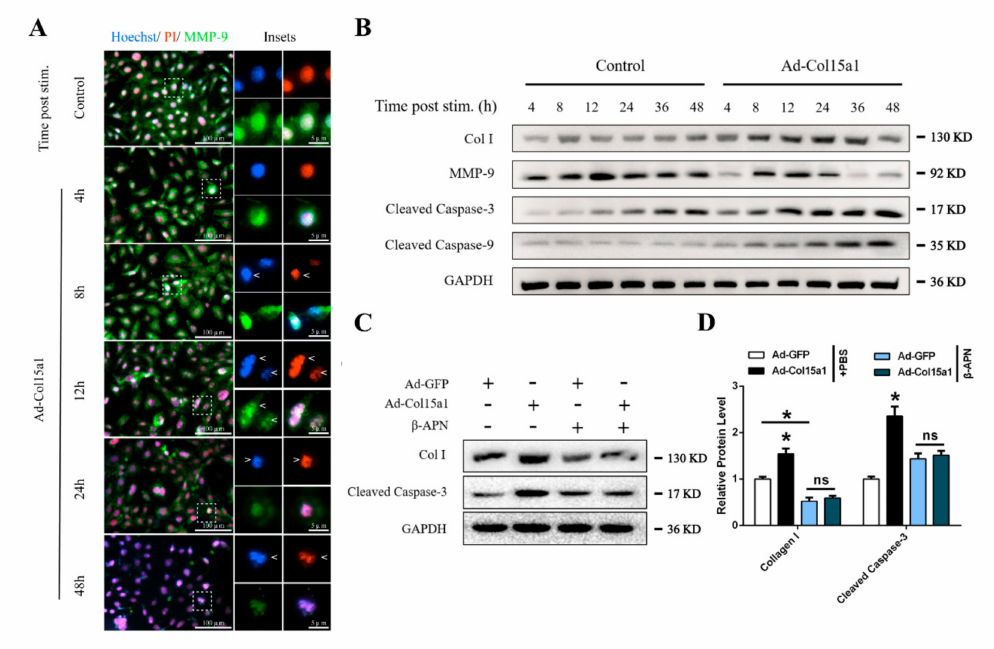
Figure 8. Abnormal ECM remodeling persistently stimulated apoptosis of adipocytes. All groups were pretreated with PA to induce adipocytes apoptosis in ( A ) and ( B ). ( A ) Representative images of adipocytes morphological characteristics in di ff erent groups with the extension of stimulation time stained by Hoechst 33258 (blue), PI (red), and MMP-9 (green). Arrowheads indicate the morphological characteristics changes of adipocytes nucleus. From top to bottom represent deformed nucleus, marginalized chromatin and disintegrated nucleus, respectively. Scale bar, 100 µ m (left) and 5 µ m (right). ( B ) Relative protein levels of Col I, MMP-9, Cleaved Caspase-3 and Cleaved Caspase-9 of adipocytes in di ff erent groups with the extension of stimulation time ( n = 4). ( C – D ) Relative protein levels of Col I and Cleaved Caspase-3 of adipocytes in di ff erent groups ( n = 4). Values are presented as mean ± SEM. * p < 0.05, ** p < 0.01, ns, not